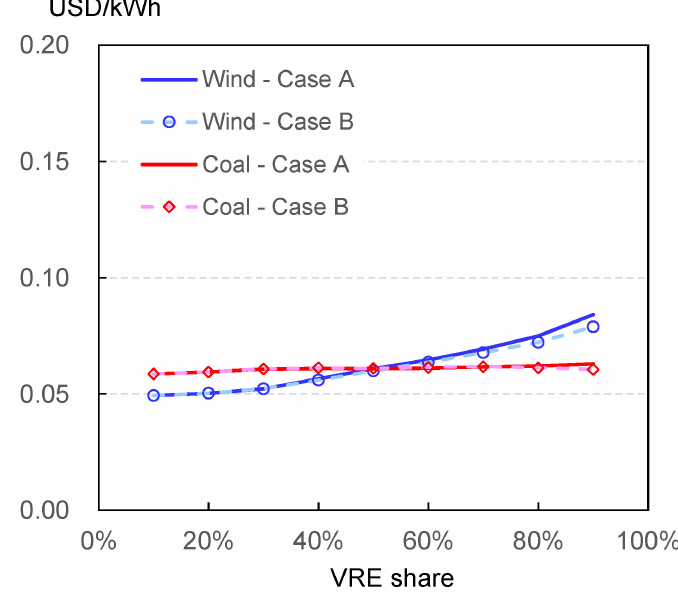
Figure 4. Average system LCOE.